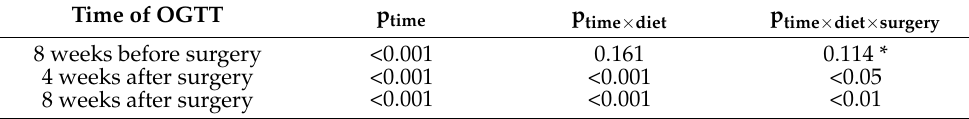
Table 2. Comparison of the oral glucose tolerance test (OGTT) results of Sprague–Dawley rats subjected to control (SHAM) and duodenojejunal omega switch (DJOS) surgery and different dietary regimes in terms of the time of glucose administration (p time ), dietary pattern and time (p time × diet ), and interaction between those parameters (p time × diet × surgery ). Statistical significance was set at p <